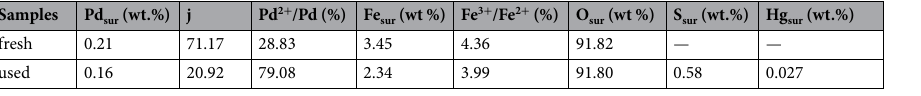
Table 1. Concentrations of elements on the surface of the fresh and used Fe 3 O 4 –NH 2 –Pd sorbents according to the XPS